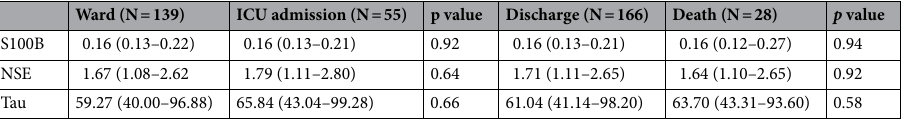
Table 5. S100B, NSE and Tau and